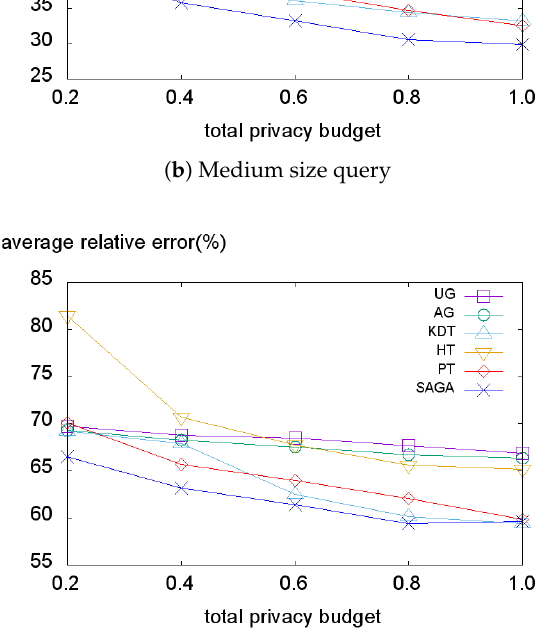
Figure 12. Average relative error on the Tdrive